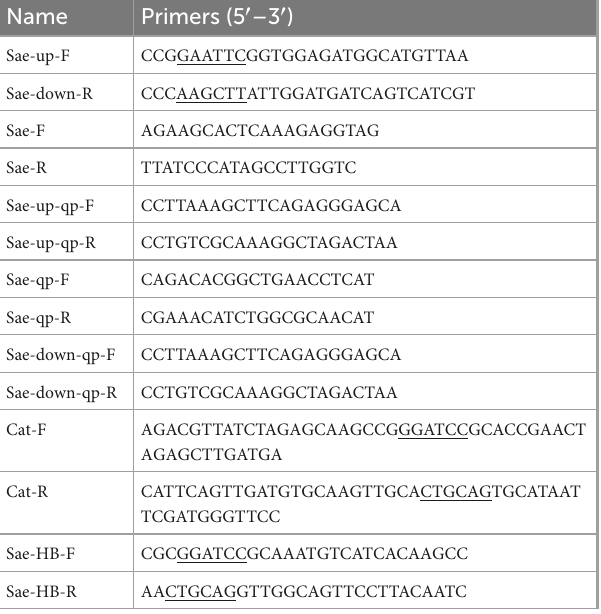
TABLE 1 List of primers mutant strain validation.